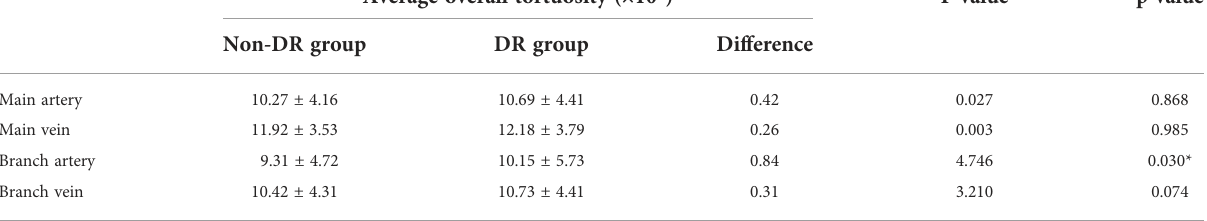
*refers to with statistically signi fi cant